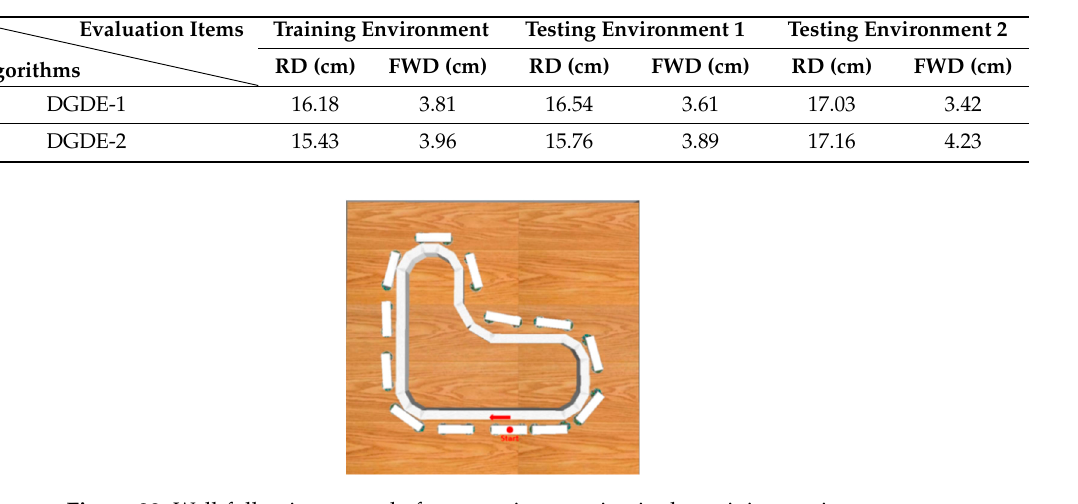
Table 6. Evaluation of the cooperative carrying performance.